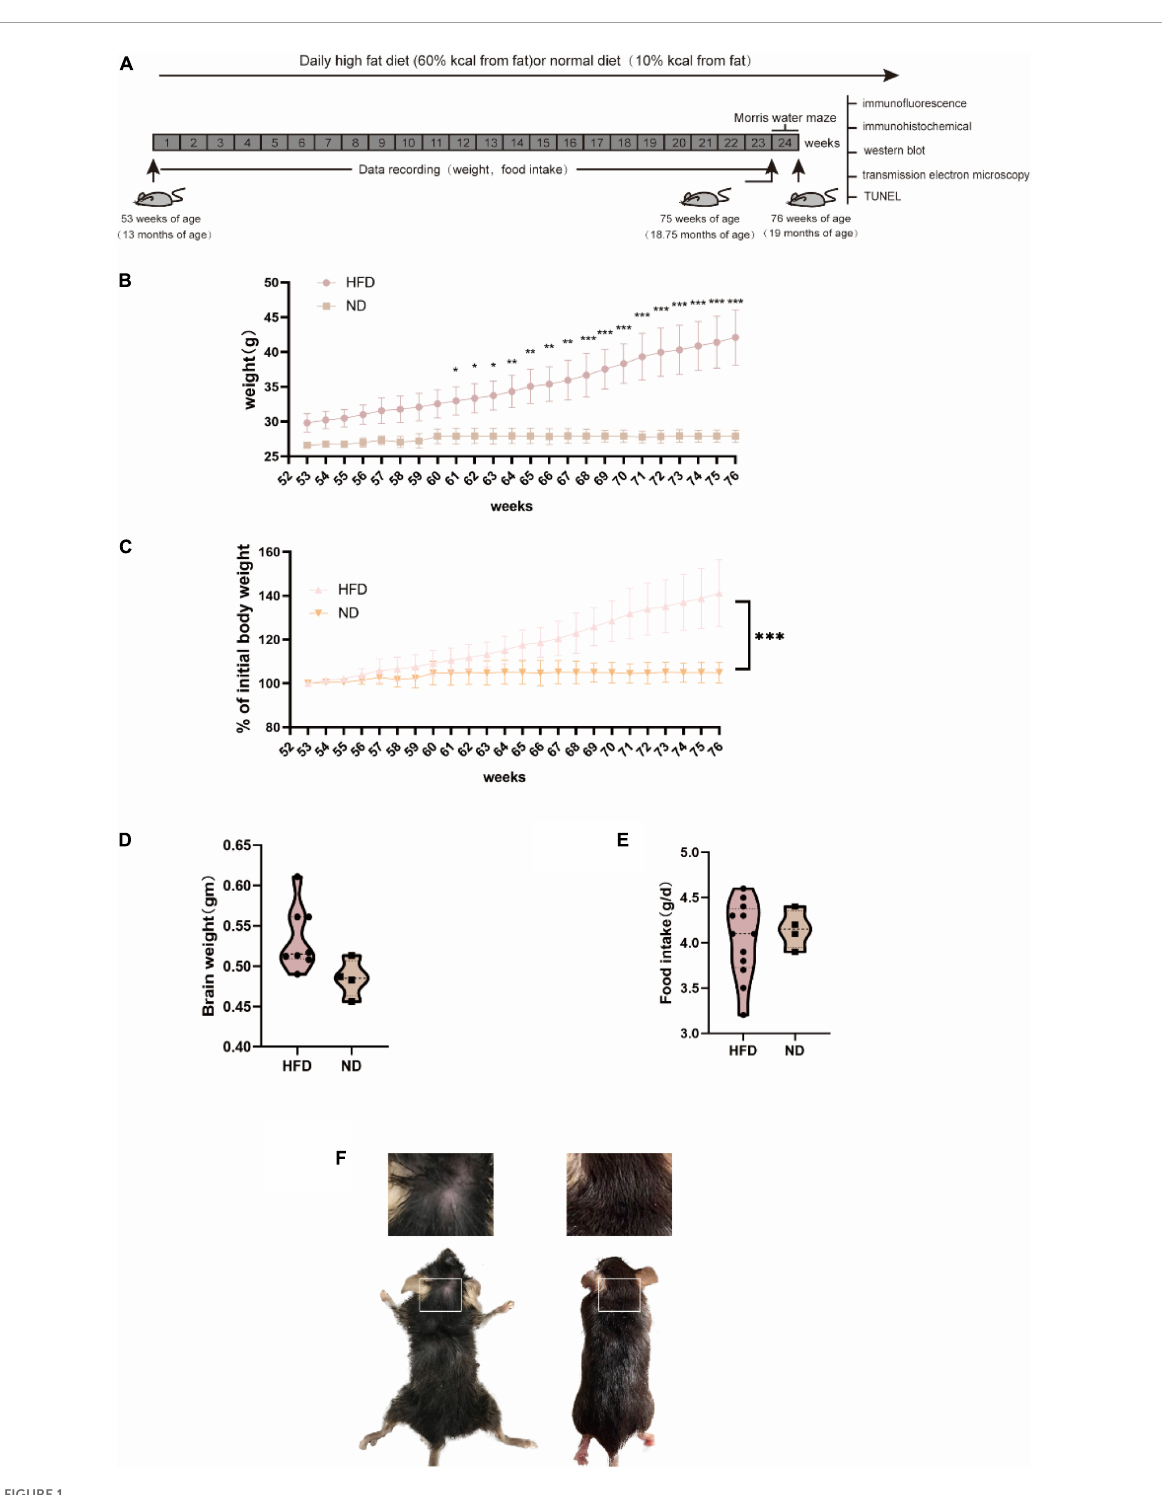
FIGURE1 General characteristics of C57BL/6 mice fed with normal diet and high-fat diet. C57BL/6 mice (13 months old) were fed a HFD or ND for 24 weeks. (A) Experiment process overview. (B) Changes in body weight over time and body weight were significantly increased after 8 weeks of HFD. (C) A percentage of the initial body weight during the course of the experiment. Body weight percentage was calculated as (actual body weight/initial body weight) × 100. (D) Alterations in food intake were not significantly different between groups. (E) (HFD, n = 20 mice; ND, n = 10 mice) (E) Brain weight did not differ between groups. (F) At the late stage, the HFD group exhibited an extremely poor status with increasingly sparse